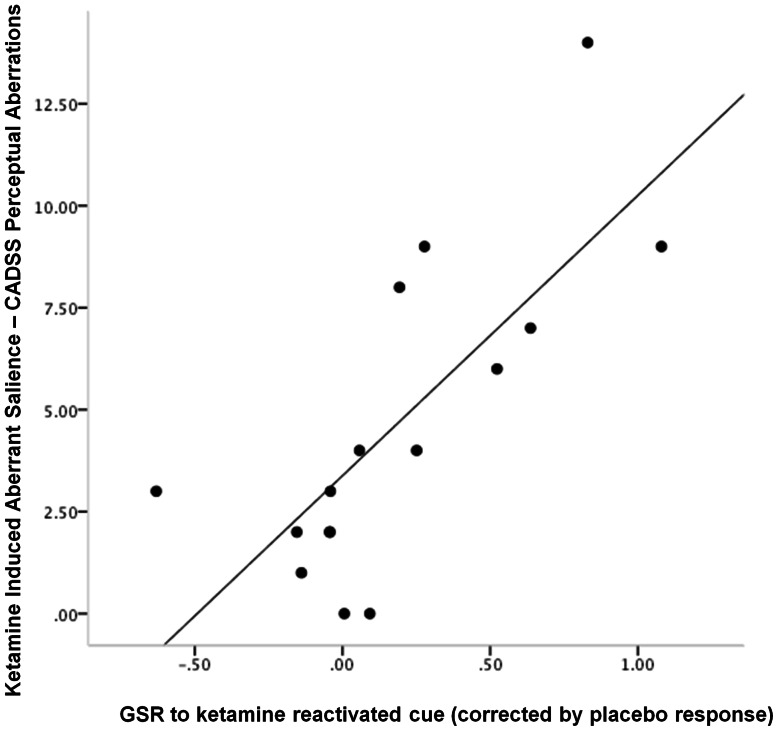
Relating Cue Responses to Psychotomimetic Response.
The relationship between ketamine induced aberrant salience and skin conductance responses to the cue reactivated under ketamine. Subjects who experienced the most severe aberrant salience also showed the strongest skin conductance responses to the cue reactivated under ketamine. Plot features the difference in GSR response to the cue reactivated under ketamine from the cue reactivated under placebo on x-axis, CADSS perceptual subscale score (e.g., endorsing that background noises seemed louder, colors seem brighter, objects appeared to stick out from the background) on the y-axis.